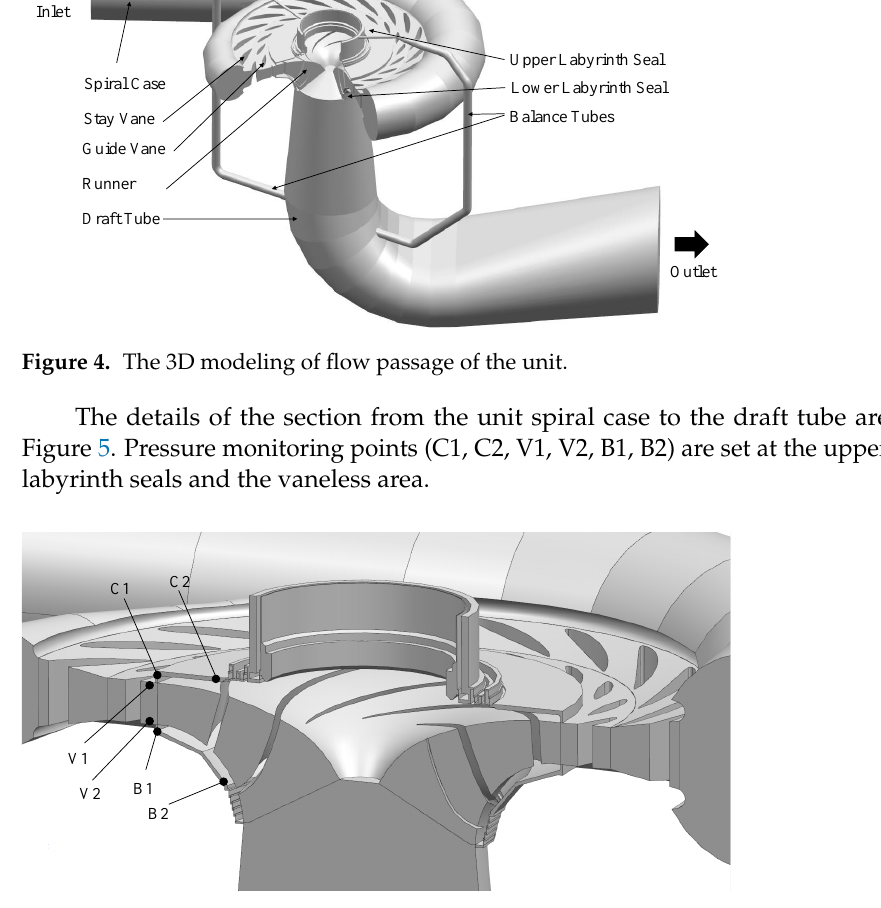
Figure 5. Setup of the monitoring